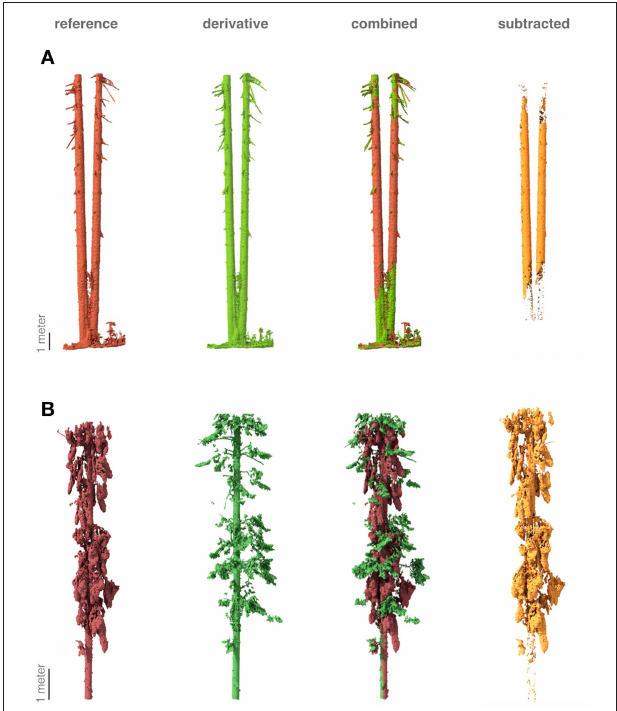
FIGURE 11 | Three-dimensional models based on TLS scans of Oyamel fir trees in central Mexico. (A) Using the SVE analytical method, we estimate that 63,378 butterflies are present on this two-trunk tree at the San Antonio site. (B) Using the same approach, we estimate that 36,995 butterflies occupied the clusters of this tree at the Carpinteros site. See also Supplementary Videos 1 , 2 .